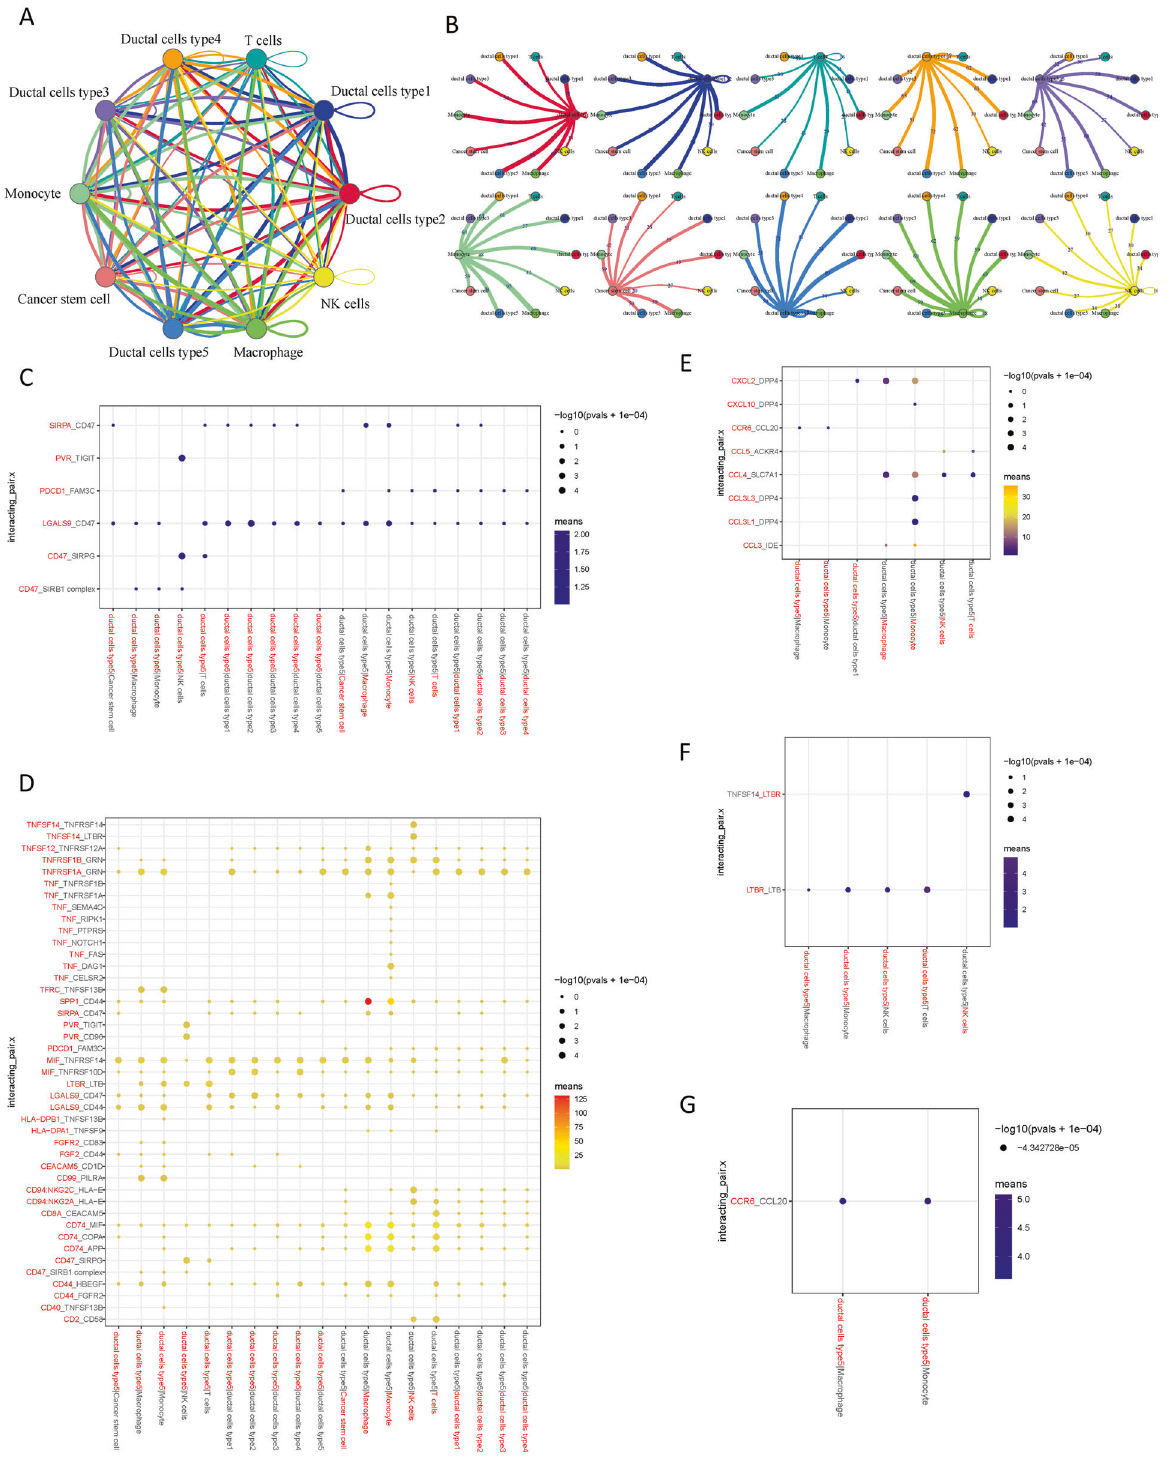
personalized treatment. Therefore, there was an urgent need to reveal the underlying molecular mechanism of intra-tumoral heterogeneity and tumor metastasis characteristics with high cellular resolution in the TME of metastatic PDAC. Herein, 10 predominant populations of cells with t-SNE clustering were identi fi ed in the metastatic PDAC biopsies that included 6 stromal cellular types and 4 immune cell